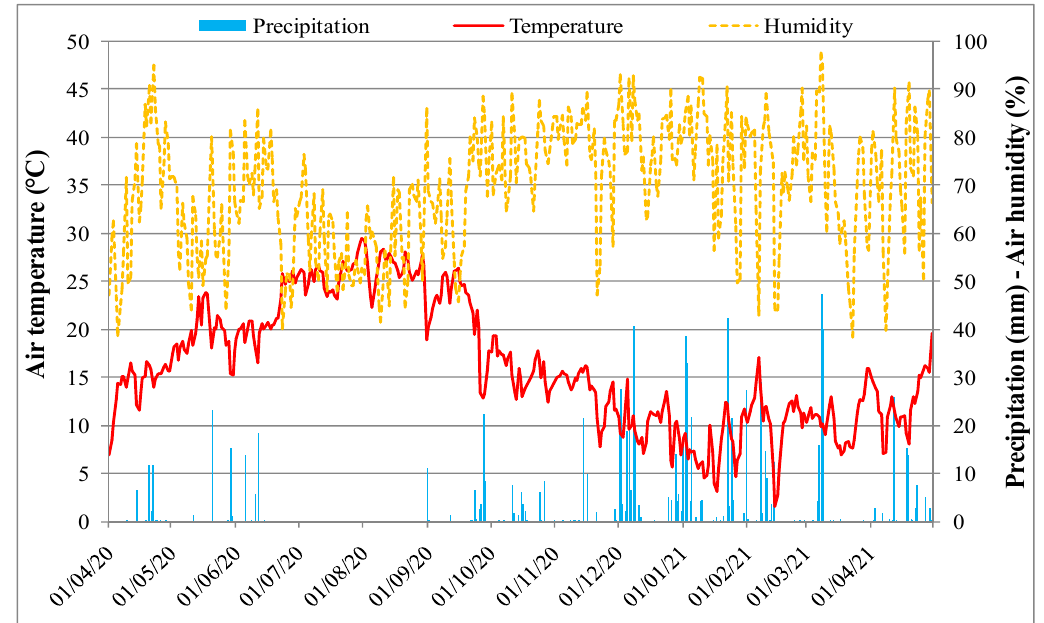
Figure 1. Trends of mean daily air temperature, mean daily air humidity and daily amount of precipitation.